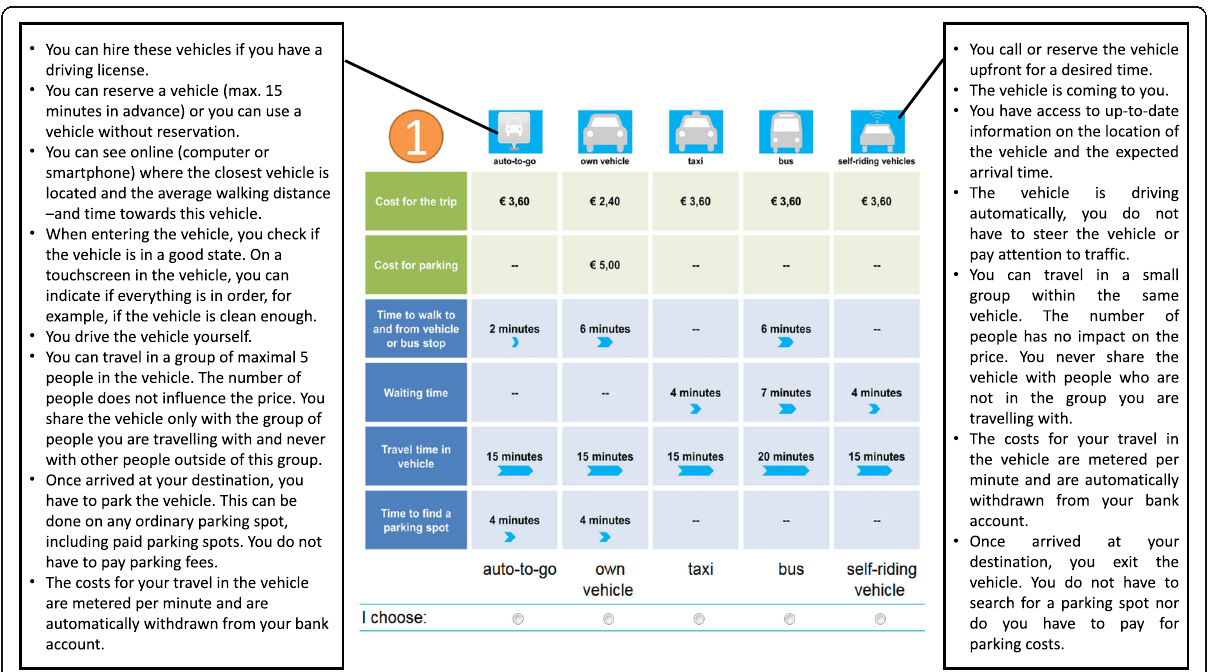
Fig. 1 Description of FFCS and SAV as presented to the participants (translated from